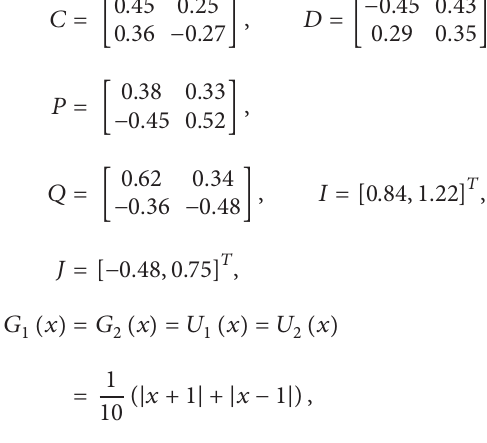
the initial values (𝑥 1 , 𝑥 2 , 𝑦 1 , 𝑦 2 )